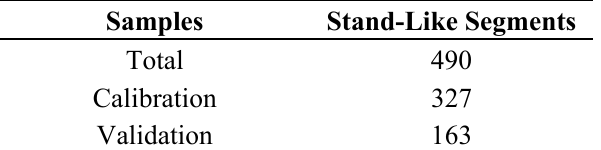
Table 5. Number of samples used for calibration and validation of the CART